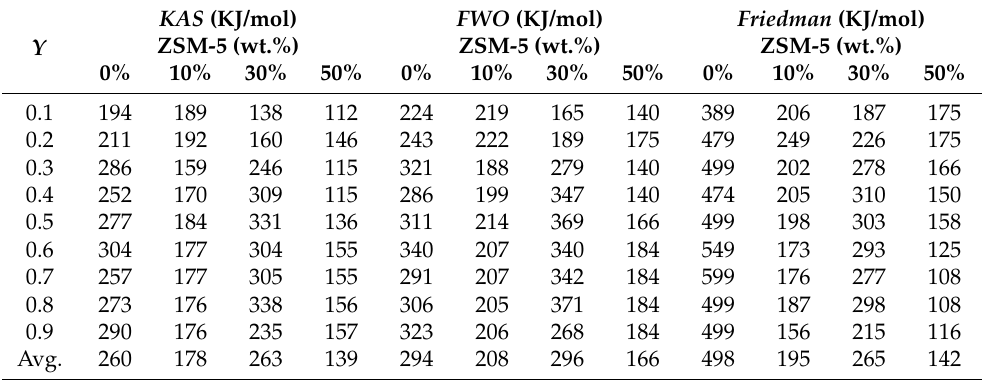
Figure 6. The apparent activation energy-conversion curves for ( A ) MFPW and ( B – D ) 10, 30, 50 wt.% of ZSM-5. Table 3. The calculated apparent activation energy at different